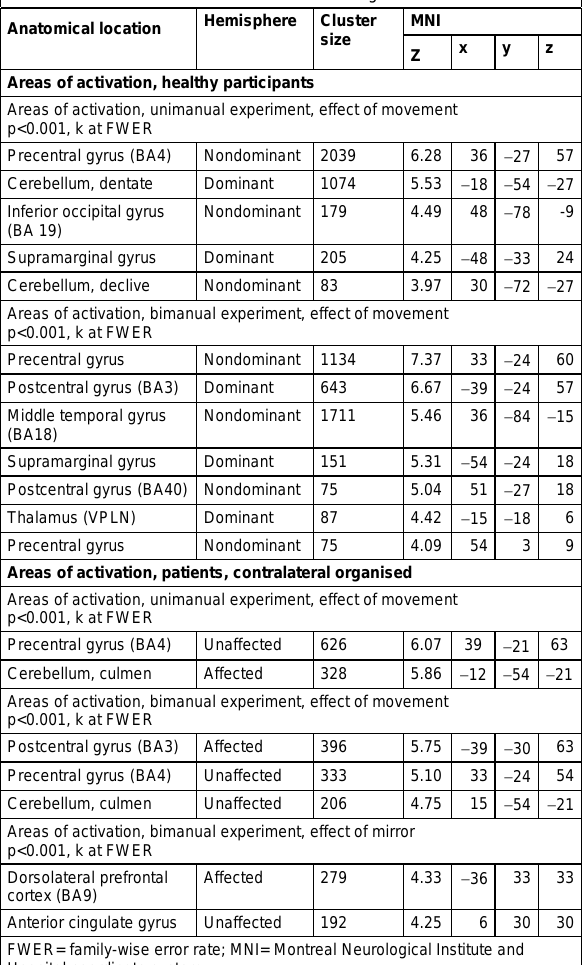
Table 2: Detailed information on all affected regions. Anatomical